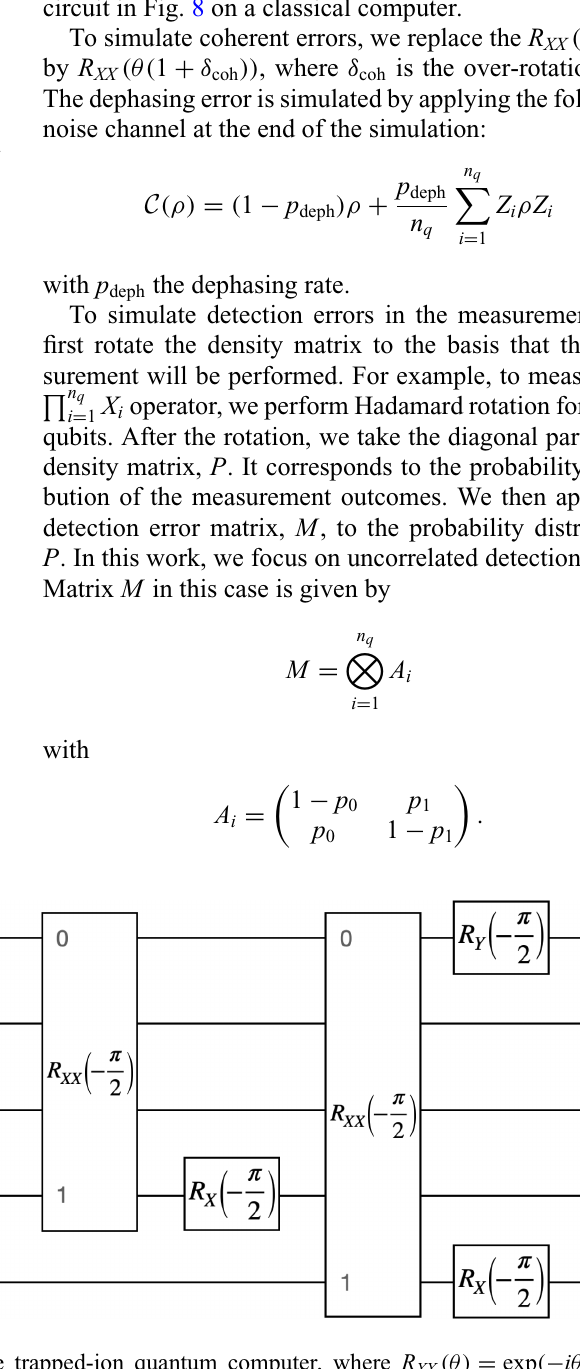
FIG. 8. The circuit used for preparing the GHZ state in the trapped-ion quantum computer, where R XX (θ) = exp ( − i θ XX / 2 ) , R α (θ) = exp ( − i σ α θ/ 2 ) and α = x , y , z